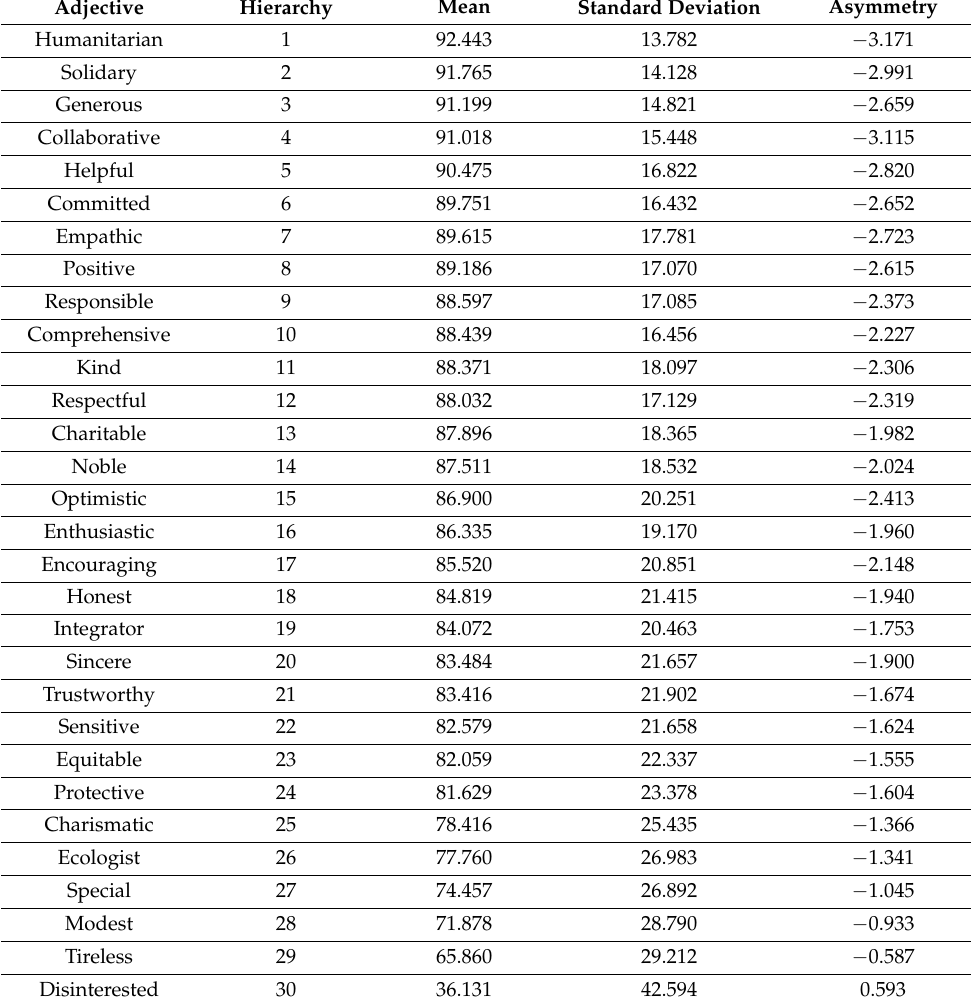
Table 2. Statistical summary of the assessment of